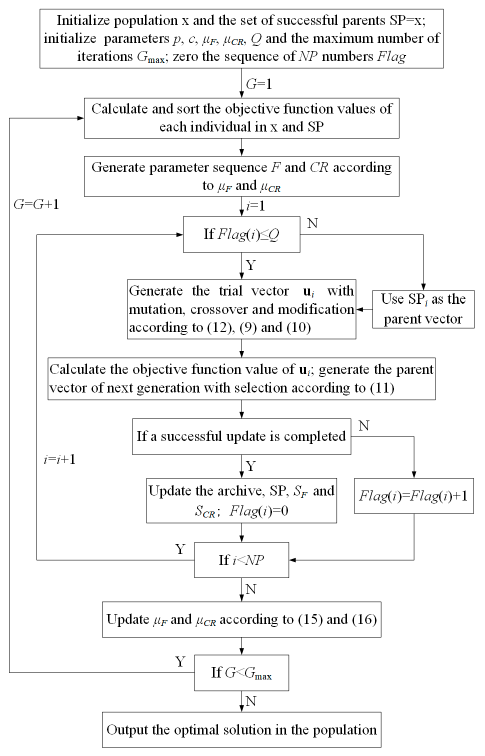
Figure 2. Flowchart of the SPS-JADE algorithm.